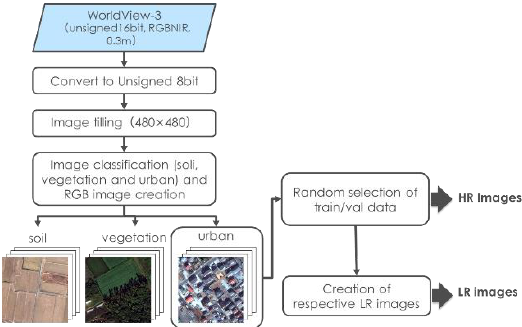
Figure 6 . Overview of dataset preparation for EXP1.